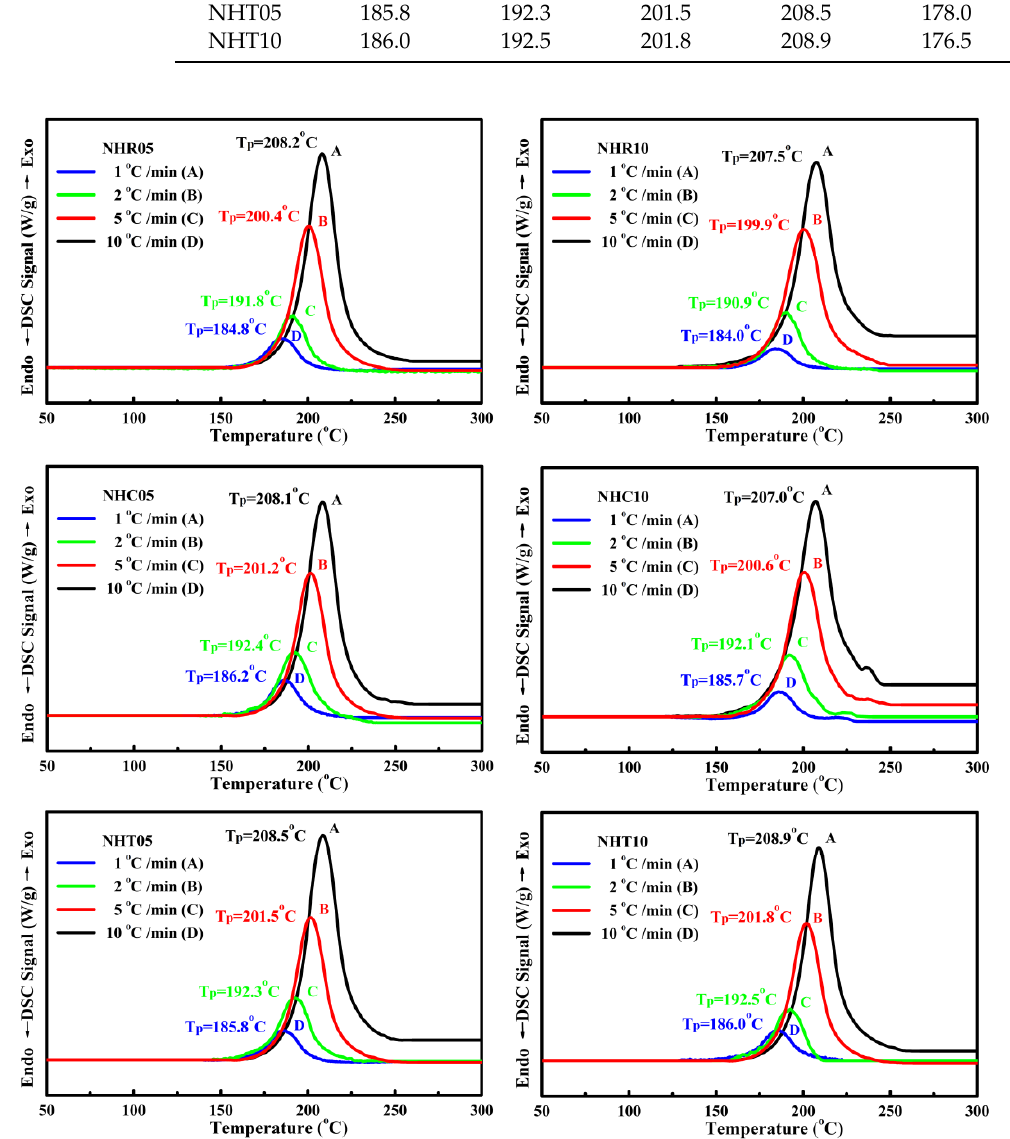
Figure 5. DSC curves of samples NHR05, NHR10, NHC05, NHC10, NHT05 and NHT10 at different heating rates of 1, 2, 5 and 10 °C min −1 . Table 2. Activation energy values of decomposition reactions of test samples calculated by the Kissinger and Ozawa methods.